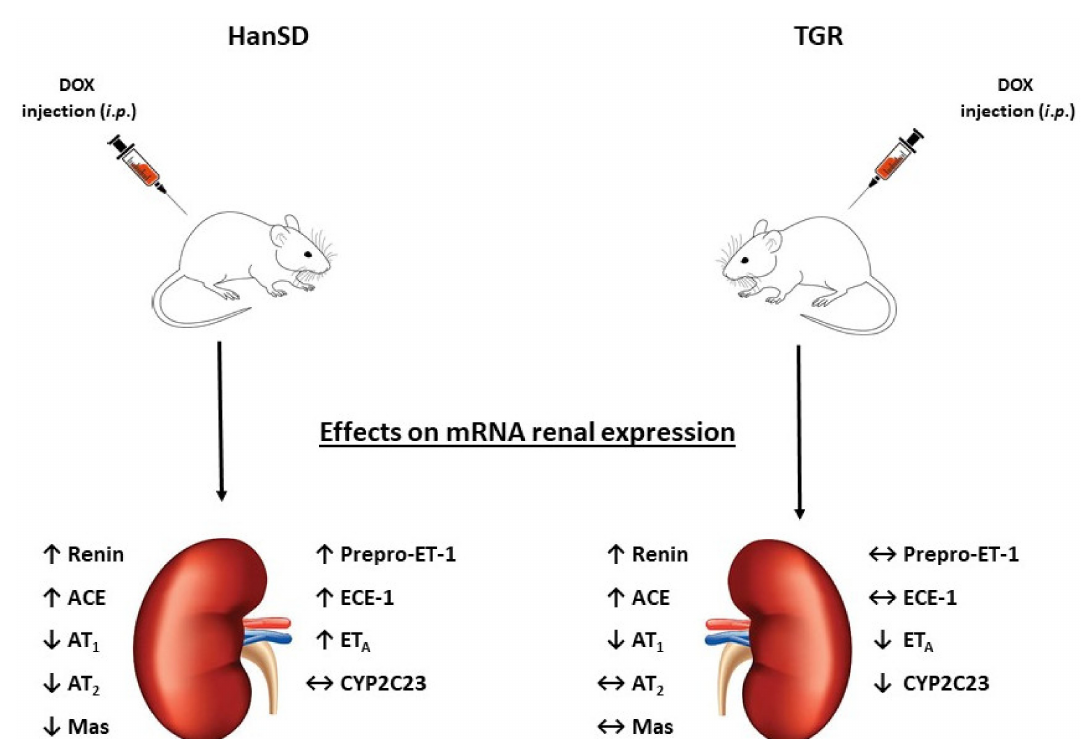
Figure 7. Graphical summary of the most important effects of doxorubicin (DOX) treatment on the intrarenal messenger ribonucleic acid (mRNA) expressions of vasoactive systems implicated in the pathophysiology of heart failure-associated cardiorenal syndrome in normotensive, transgene-negative Hannover Sprague–Dawley (HanSD) rats and hypertensive, Ren-2 transgenic (TGR) rats. Specifically, renin, angiotensin-converting enzyme (ACE), angiotensin II type 1 (AT 1 ) recep- tor, angiotensin II type 2 (AT 2 ) receptor, Mas receptor (Mas), prepro-endothelin-1 (Prepro-ET-1), endothelin-converting enzyme type 1 (ECE-1), endothelin type A (ET A ) receptor and cytochrome P-450 subfamily 2C23 (CYP2C23). ( ↓ ) indicates downregulation, ( ↑ ) indicates upregulation, ( ↔ ) indicates no significant